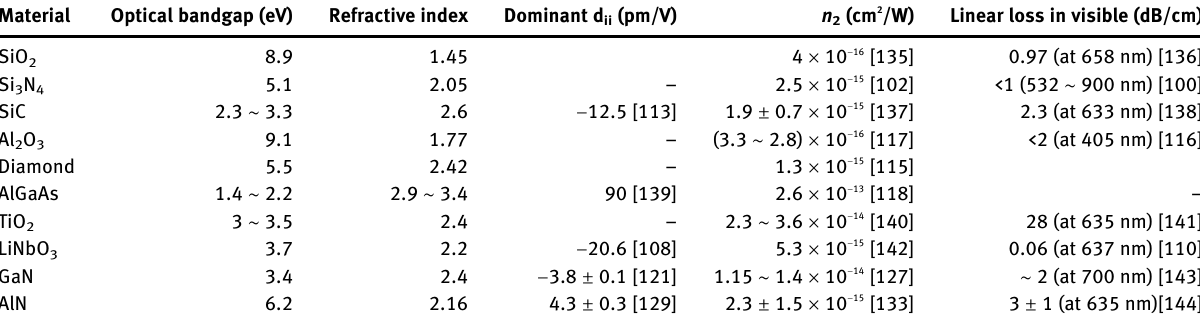
Table  : Nonlinear optical properties of III-N in comparison with other materials.